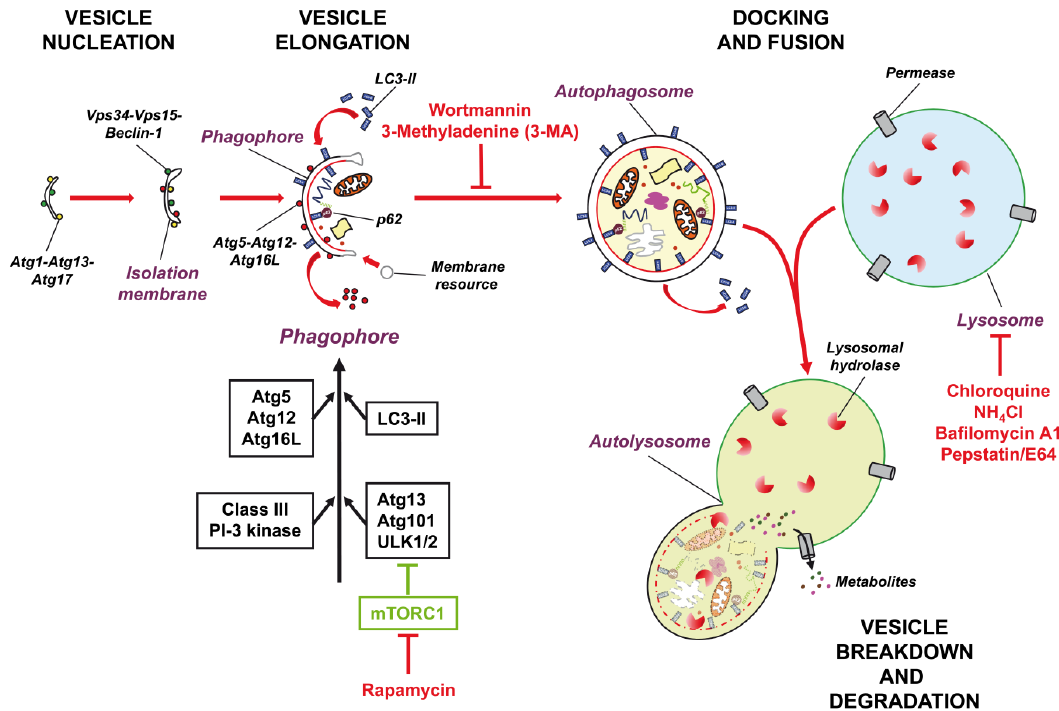
Figure 1. Model of autophagic flux and common inhibitors of the macroautophagic pathway. Macroautophagy involves autophagosome formation, delivery of